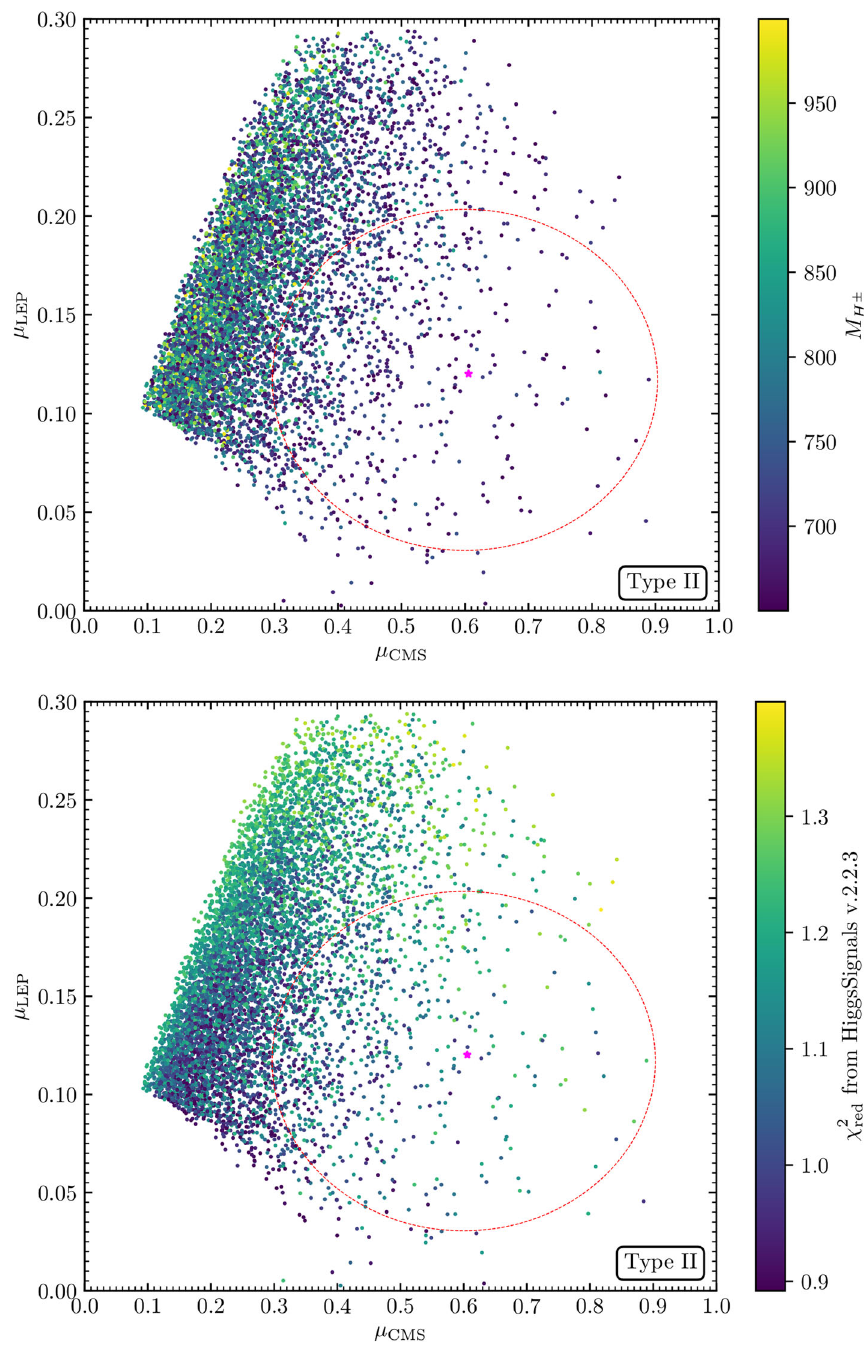
Fig. 1 Type II: the signal strengths μ CMS and μ LEP are shown for each scan point respecting the experimental and theoretical constrains. The 1 σ -region of both excesses is shown by the red ellipse. The colors show the mass of the charged Higgs. The magenta star is the best-fit point. The lowest (highest) value of M H ± inside the 1 σ ellipse is 650 . 03 ( 964 . 71 ) GeV